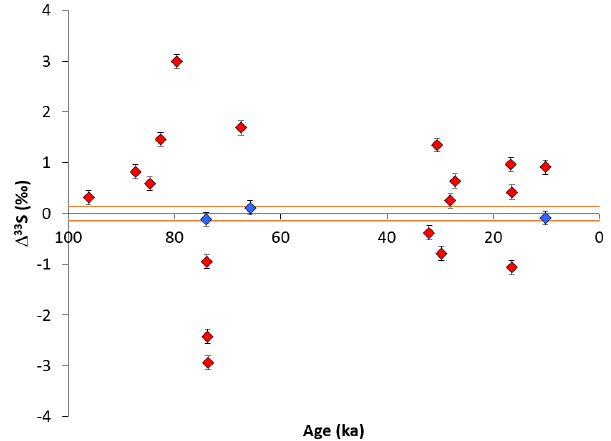
Figure 8. Values of (cid:49) 33 S for 21 large volcanic eruptions recorded at Dome C in the last 100kyr. Values outside a range of ± 0 . 14‰ are considered to indicate a stratospheric